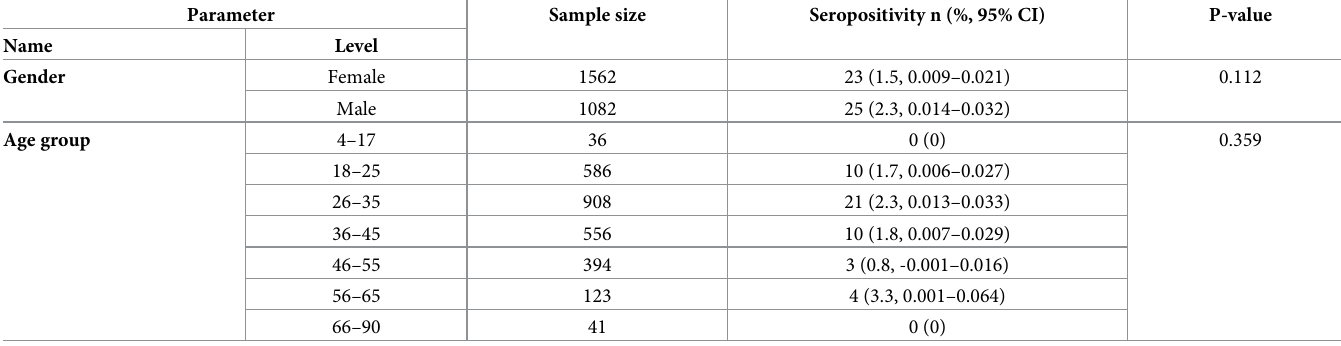
Table 1. HBV prevalence according to age among outpatient clinic attendees in Kenya in 2015.